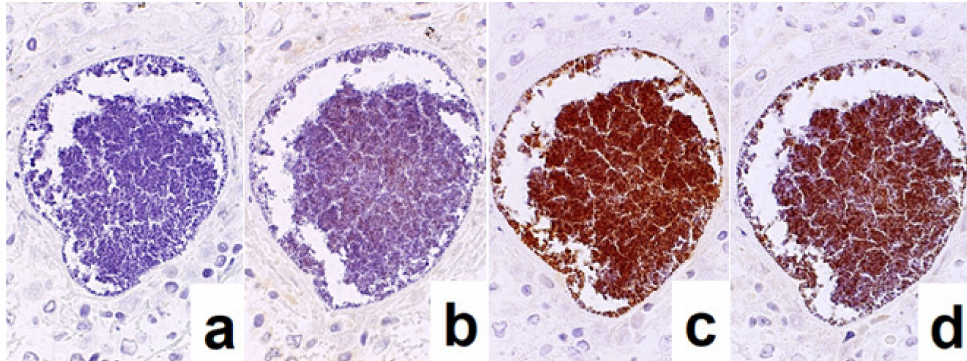
Figure 20. Retrieval of protein A activity on methicillin-resistant Staphylococcus aureus (MRSA) by heating pretreatment in 1 mM EDTA, pH 8. MRSA infection in the lung. ( a ): Without primary antibody (negative control), ( b ): incubation with rabbit antibody, F(ab’)2 fragments, against mouse immunoglobulins, ( c ): incubation with rabbit antibody, whole IgG, against mouse immunoglobulins and ( d ): incubation with mouse monoclonal antibody against Pseudomonas aeruginosa as an indifferent antibody. It is evident that the MRSA colony in the lung binds to rabbit and mouse IgG, as shown in panels c and d , respectively. The F(ab’)2 fragments of IgG lack this binding ( b ), so the nonspecific binding is caused through the Fc portion of